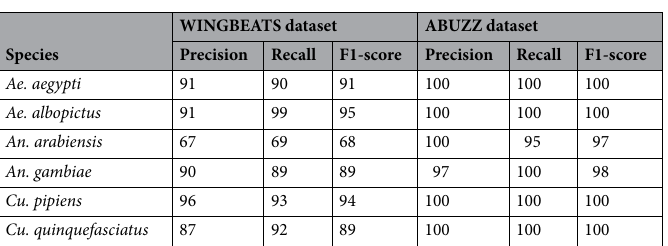
Table 1. WbNet evaluation metrics for different mosquito